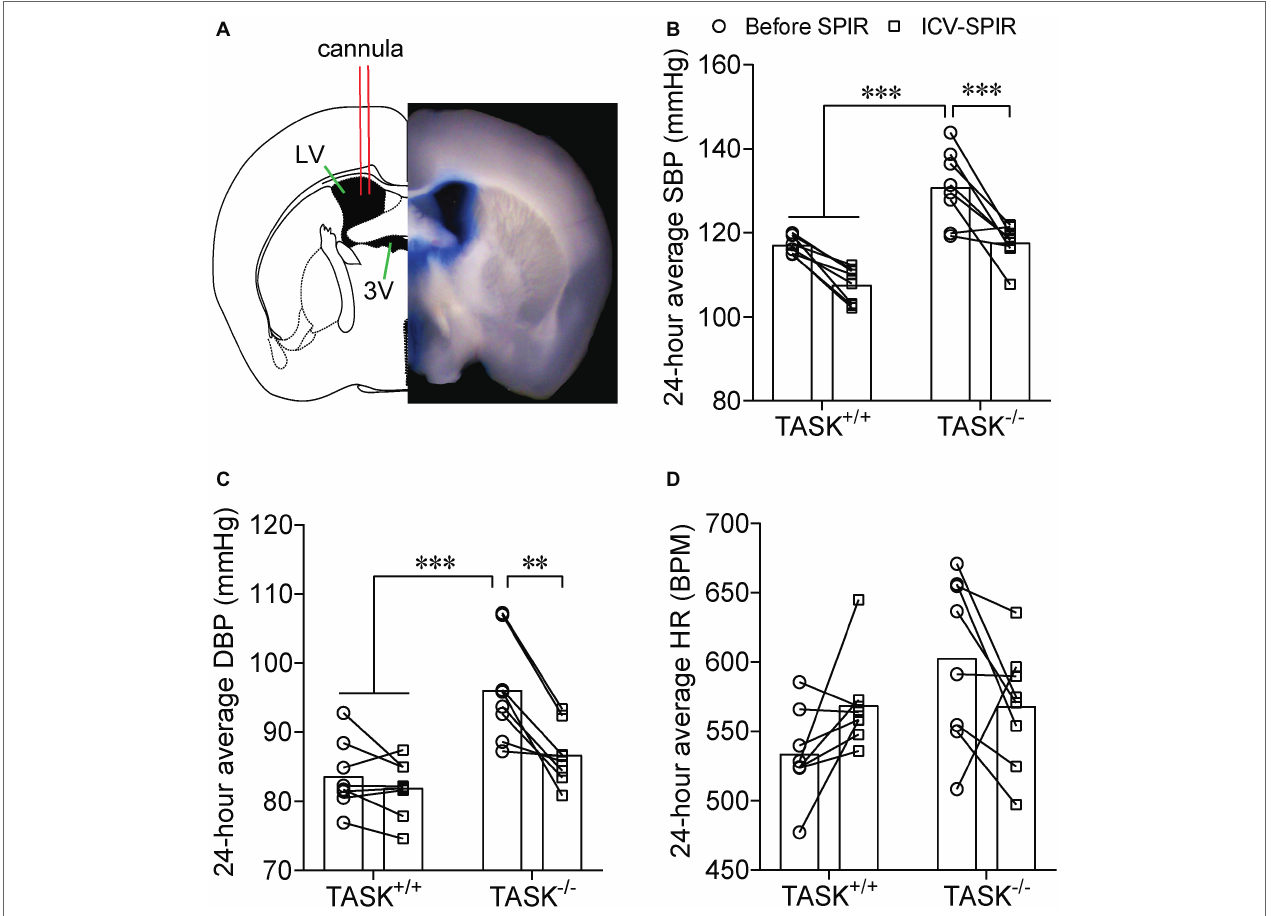
FIGURE 4 | Effect of central MR blockade on arterial pressure. SPIR was centrally given via an ICV injection once daily for 7 days in TASK +/+ and TASK − / − mice ( n = 8 for each genotype). (A) Shows a schematic diagram of ICV injection (left) and a half slice image (right) of ICV injection of the Evans Blue. Application of SPIR considerably lowered 24-h average SBP (B) and DBP (C) TASK − / − mice, without significant impact on TASK +/+ mice. No obvious difference was found in HR (D) in both genotypes. ** p < 0.01, *** p < 0.001 as indicated by two-way ANOVA with Tukey’s multiple comparisons test. ICV, intracerebroventricular; LV, lateral ventricle; 3V, third